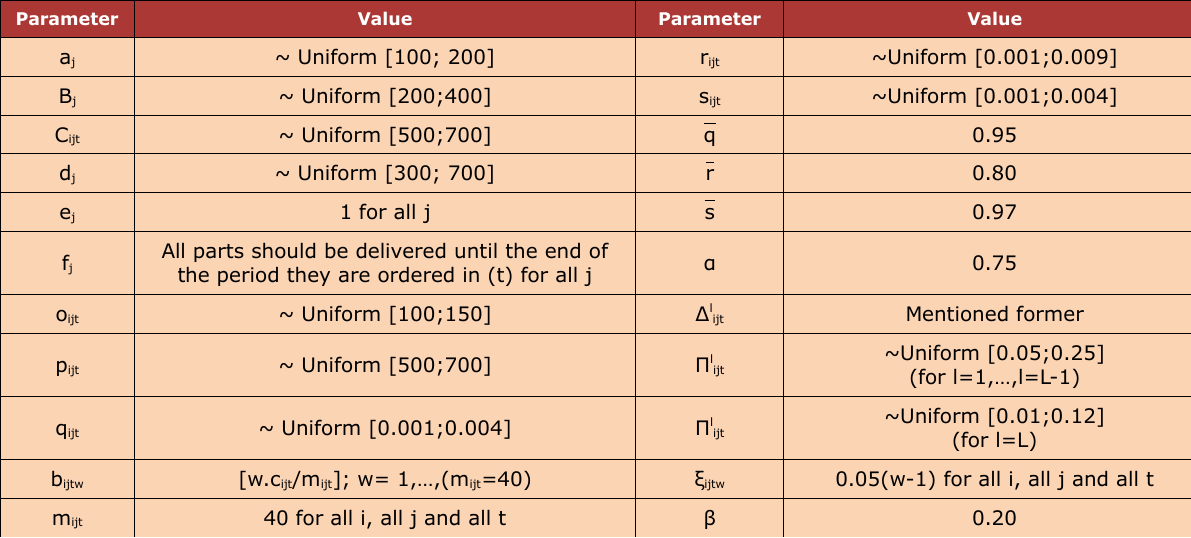
Table 15. Values of all